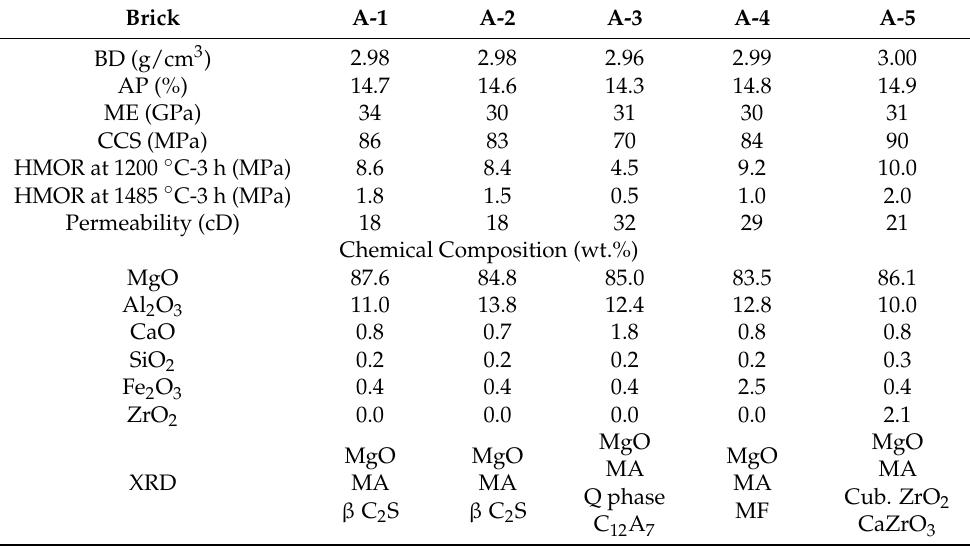
Table 3. Properties of magnesia–spinel brick compositions fired at 1500 ◦ C.